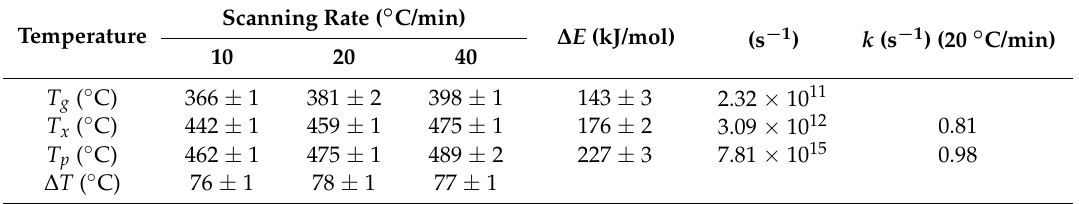
Table 1. The characteristic temperatures, activation energy, and crystallization constant of as-cast.